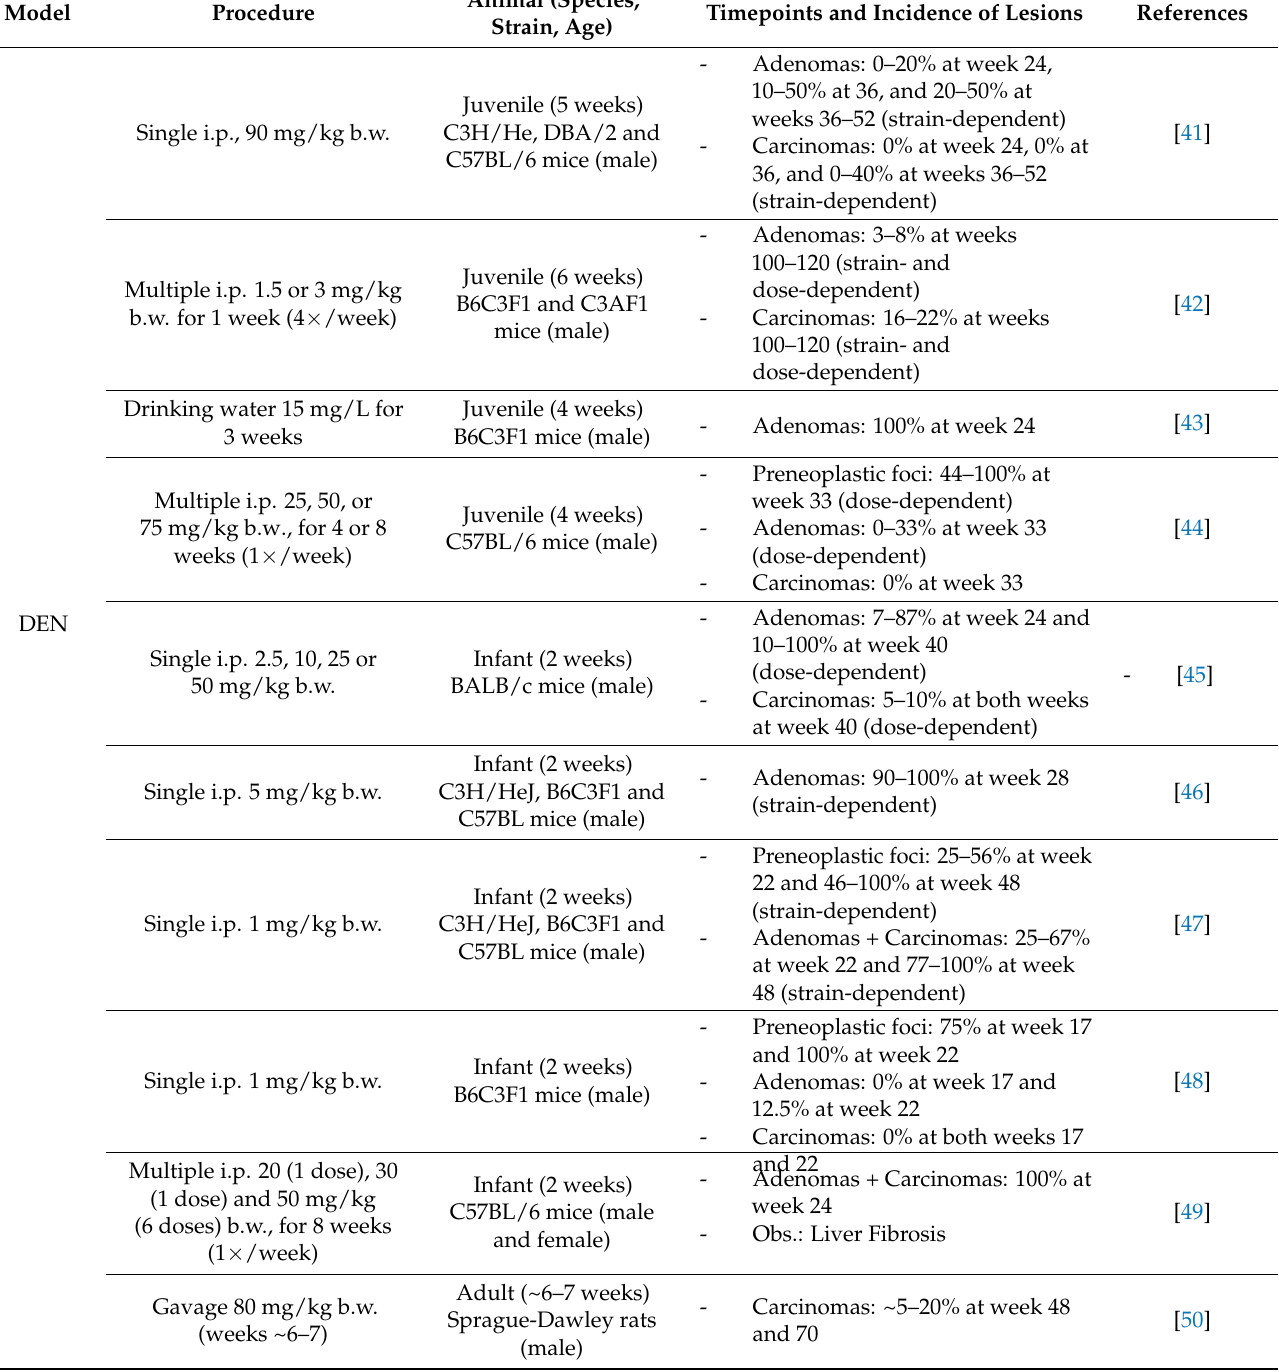
Table 2. Summary of some of the chemically induced hepatocarcinogenesis protocols in rats and mice strains.